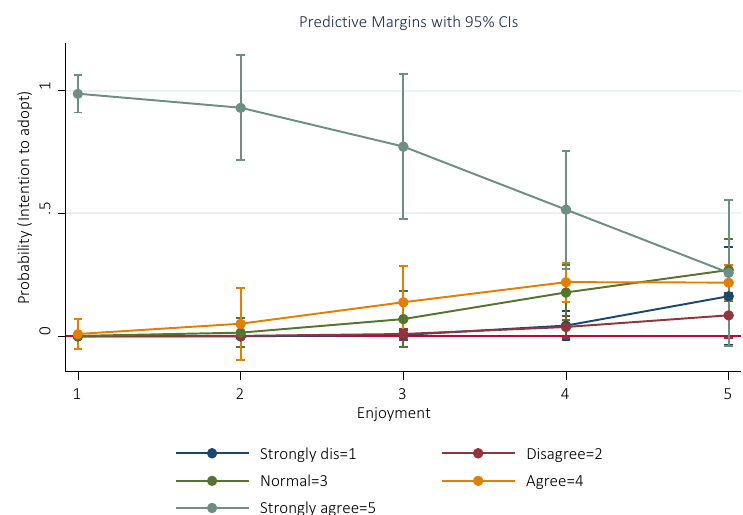
Figure 3. Marginal effects of interaction between economic benefit and enjoyment on the probability of intention to join the gig economy (in the South)